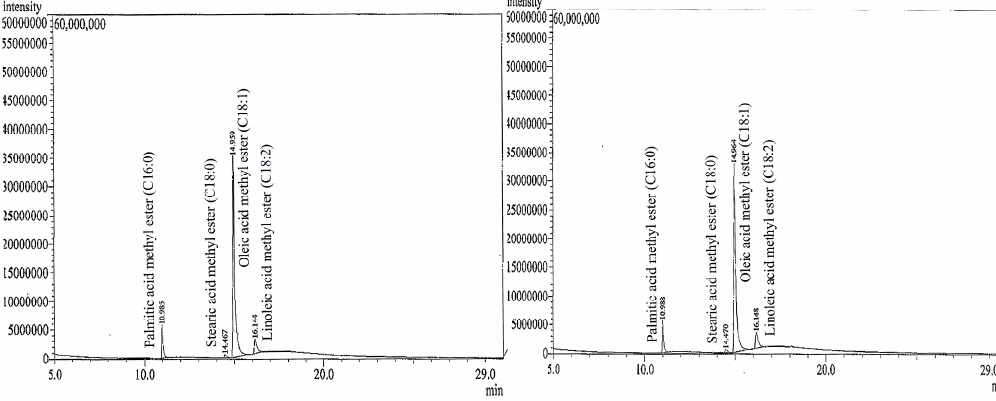
Figure 4. GC-MS chromatograms of tea seed oil ( left ) and SEOF (A1) ( right ) after transesterification.